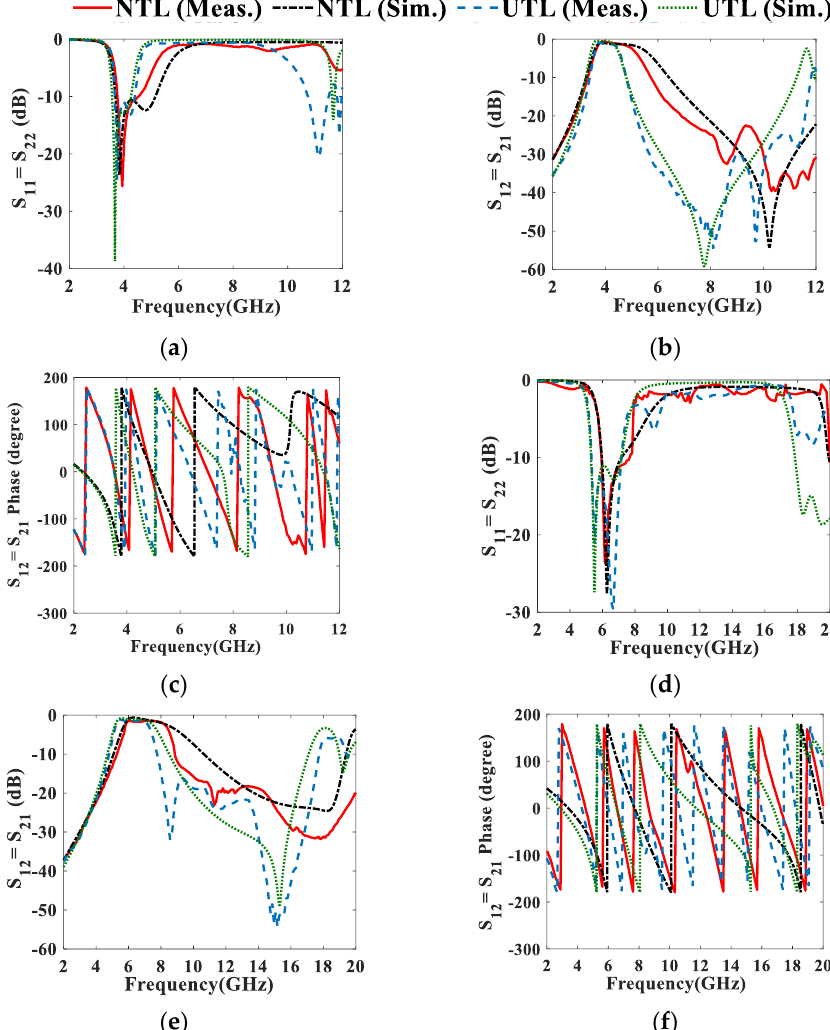
Figure 11. Simulated and measured ( a , b ) S 11 , ( c , d ) S 12, and ( e , f ) phase of the proposed (3.7–4.2 GHz)